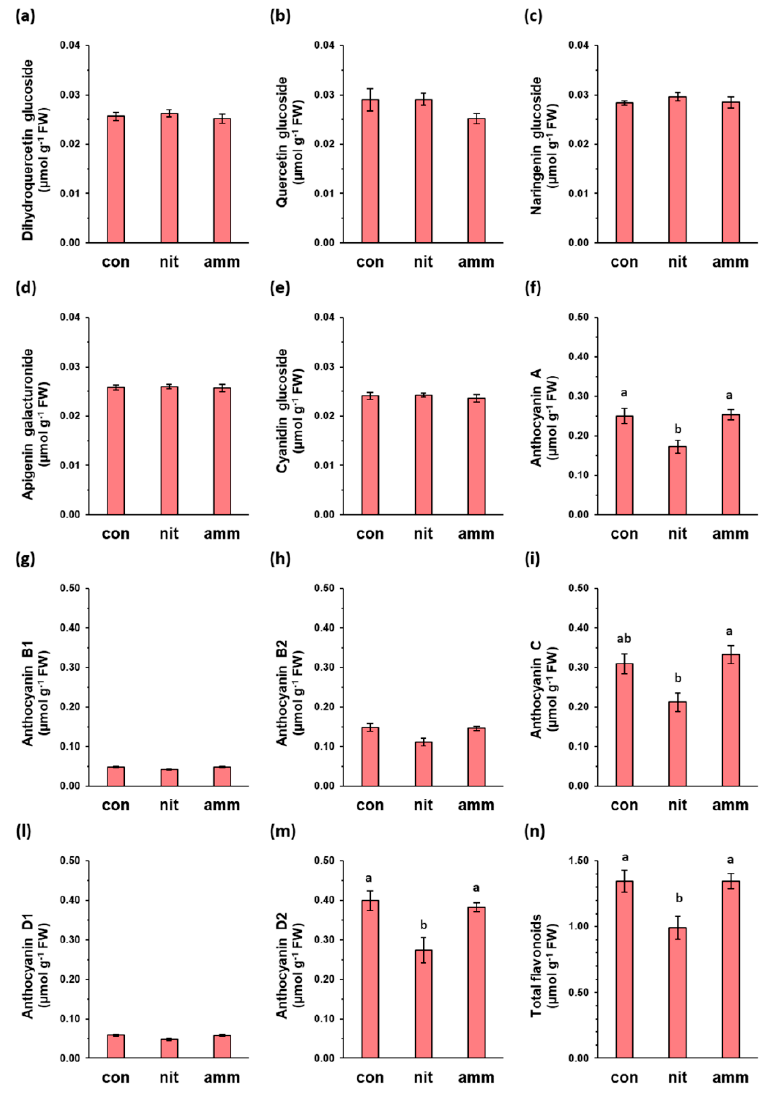
Figure 4. Contents of flavonoids in basil leaves in the purple cultivar ‘Red Rubin’. Plants were exposed for 5 d to absence of N—control [con], or to 10 mM NO 3 − —nitrate [nit], or to 10 mM NH 4 + —ammonium [amm]. Contents of: ( a ) dihydroquercetin glucoside; ( b ) quercetin glucoside; ( c ) naringenin glucoside; ( d ) apigenin galacturonide; ( e ) cyanidin glucoside; ( f ) anthocyanin A; ( g ) anthocyanin B1; ( h ) anthocyanin B2; ( i ) anthocyanin C; ( l ) anthocyanin D1; ( m ) anthocyanin